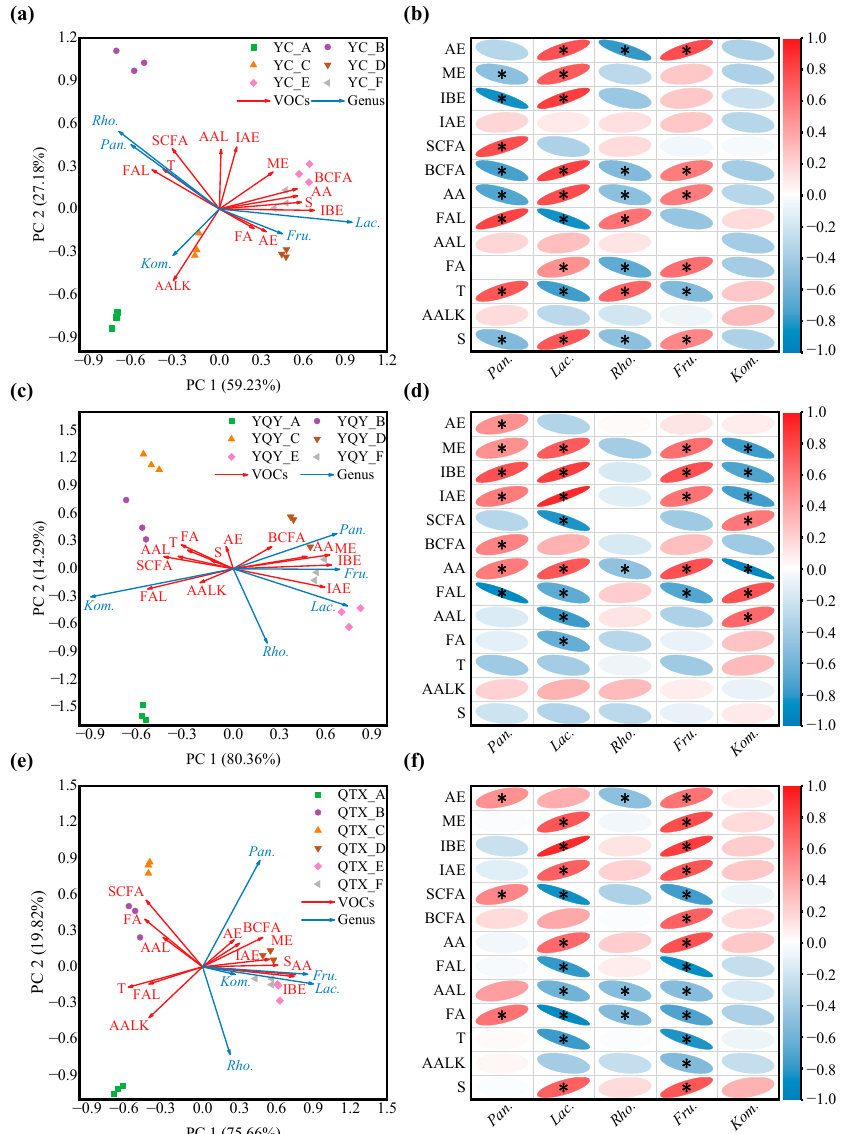
was not significant (Figure 7b).